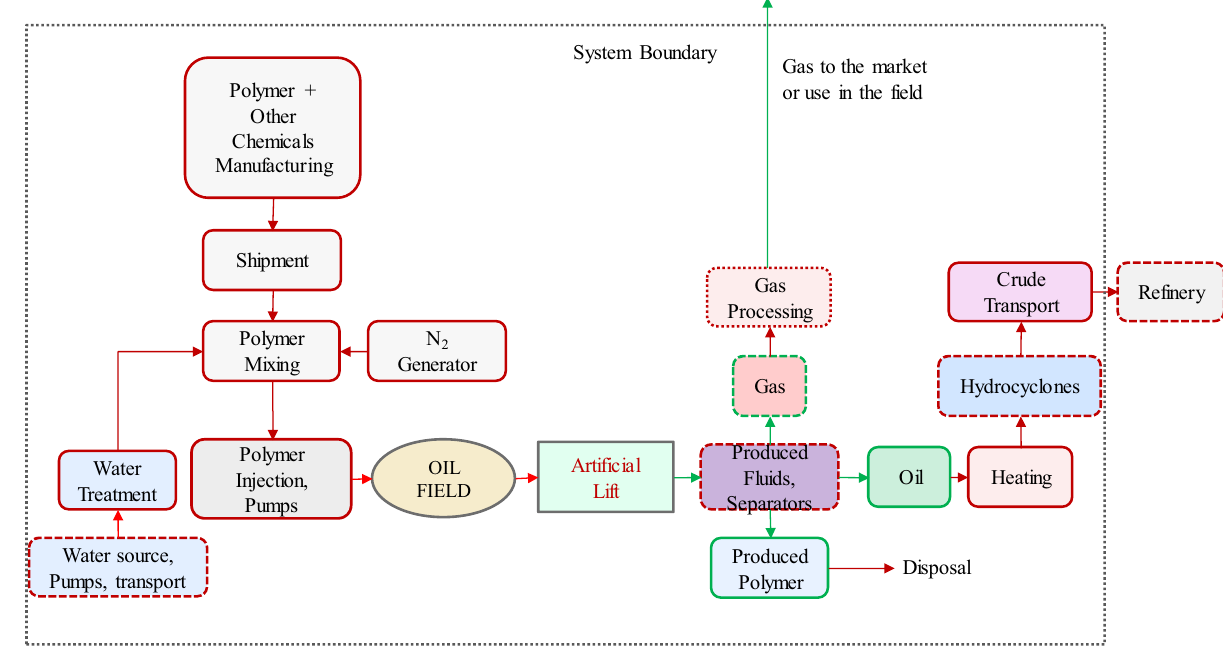
Figure 1. Schematic of the production cycle system and the selected boundary considered in this work for the production of oil by the injection of chemicals like polymer and surfactant. The boxes with the broken lines are either not considered in the calculations or assumed to have a negligible impact on the outcome. The red arrows are for the components with only exergy investment, while the green arrows contain part of the gained